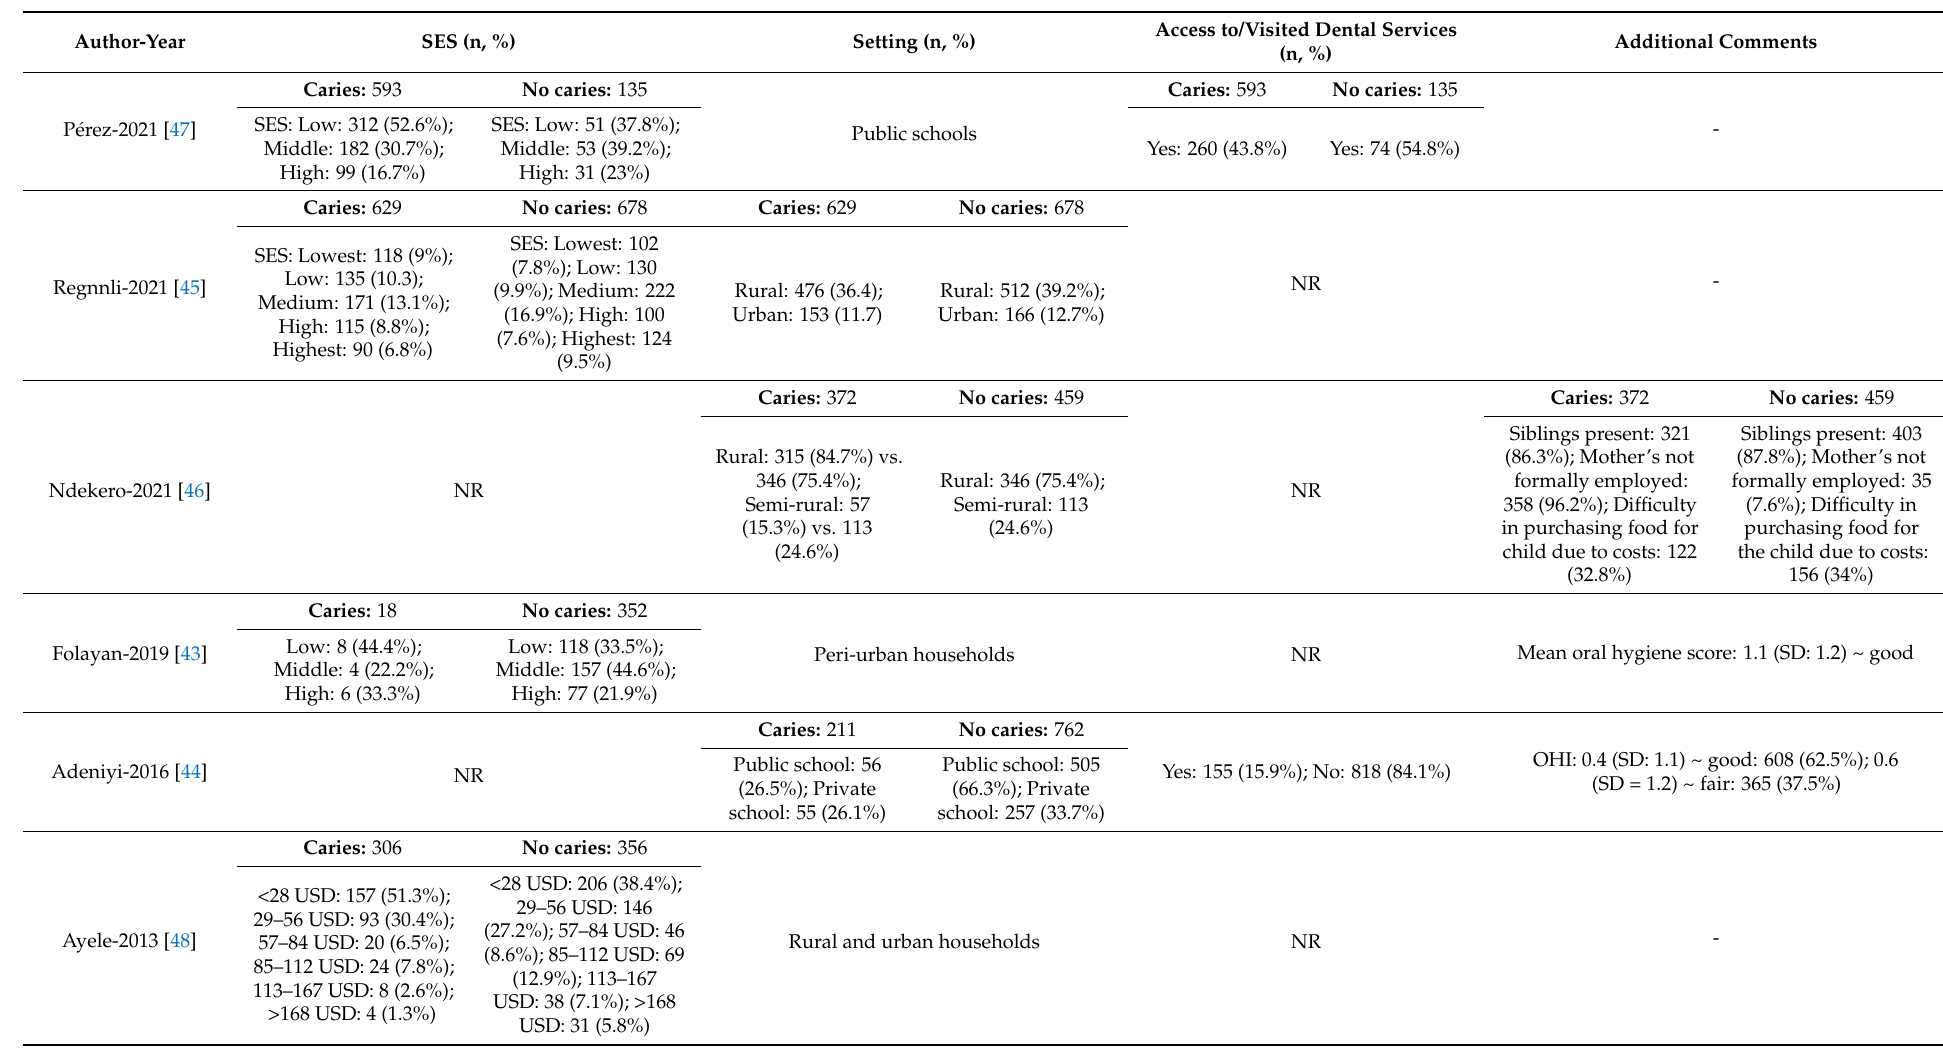
Table 4. Socioeconomic-level characteristics of eleven